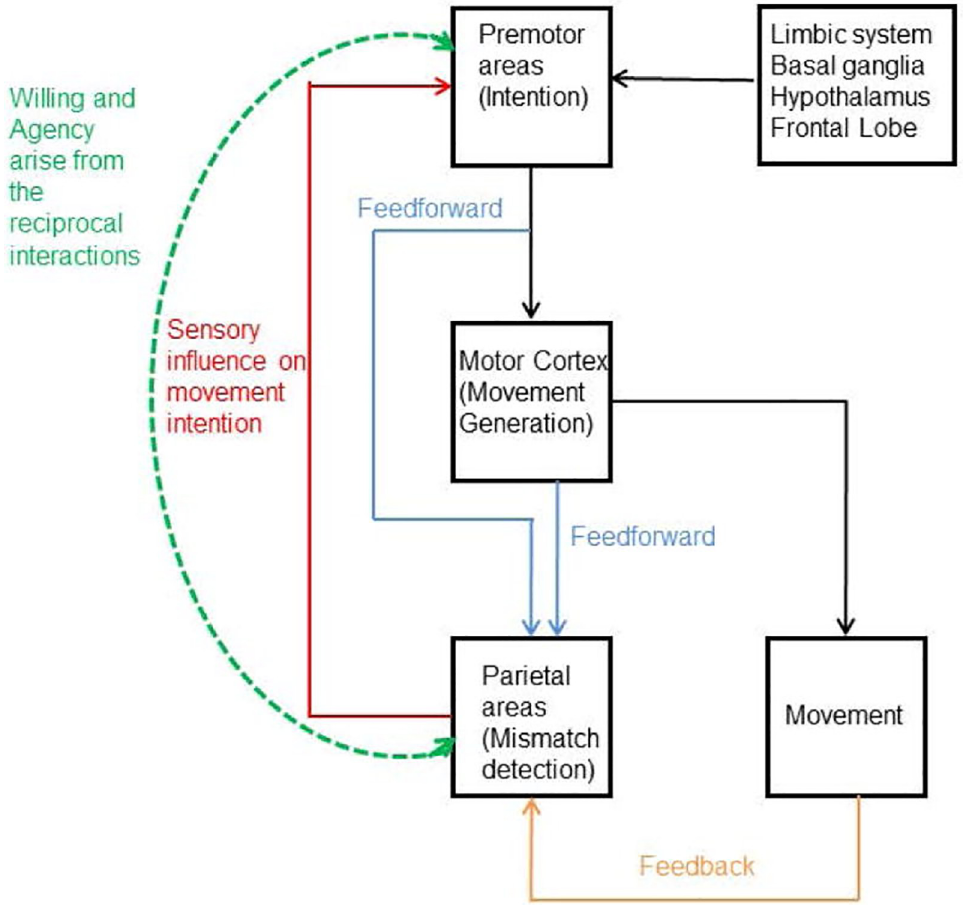
Fig 1. Voluntary motor pathway (reproduced from Hallett, 2016) illustrates the voluntary motor pathway depicting the involvement of the parieto-frontal network in both volition and sense of agency.